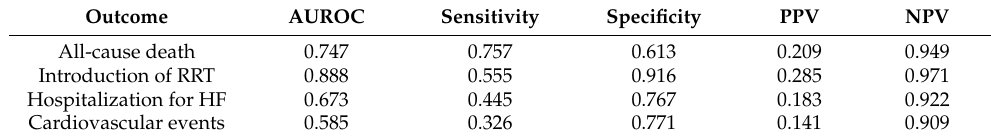
Table 3. Prediction performance of the extreme gradient boosting models on the external validation set.